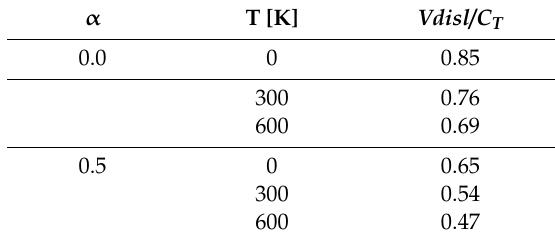
Table 3. Dislocation speed Vdisl / C T at di ff erent temperature and biaxiality ratio α = σ B / σ